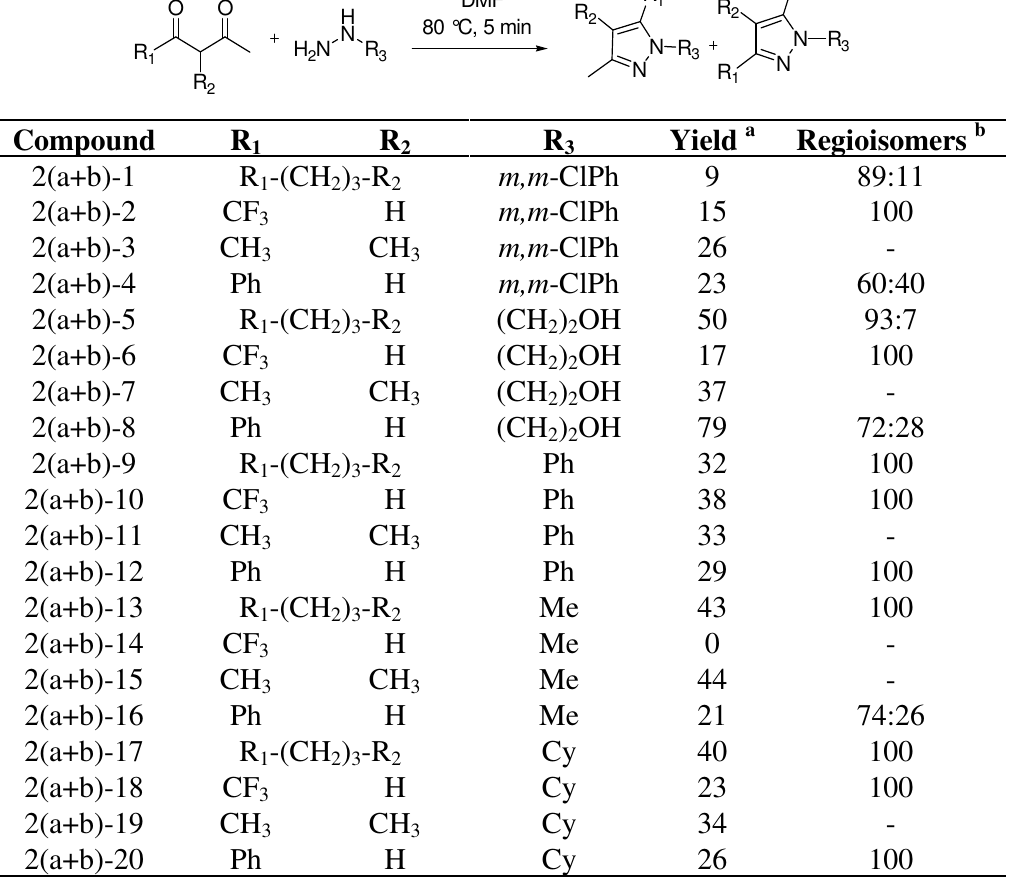
Table 2. Twenty member pyrazole library synthesized in droplets using a continuous flow